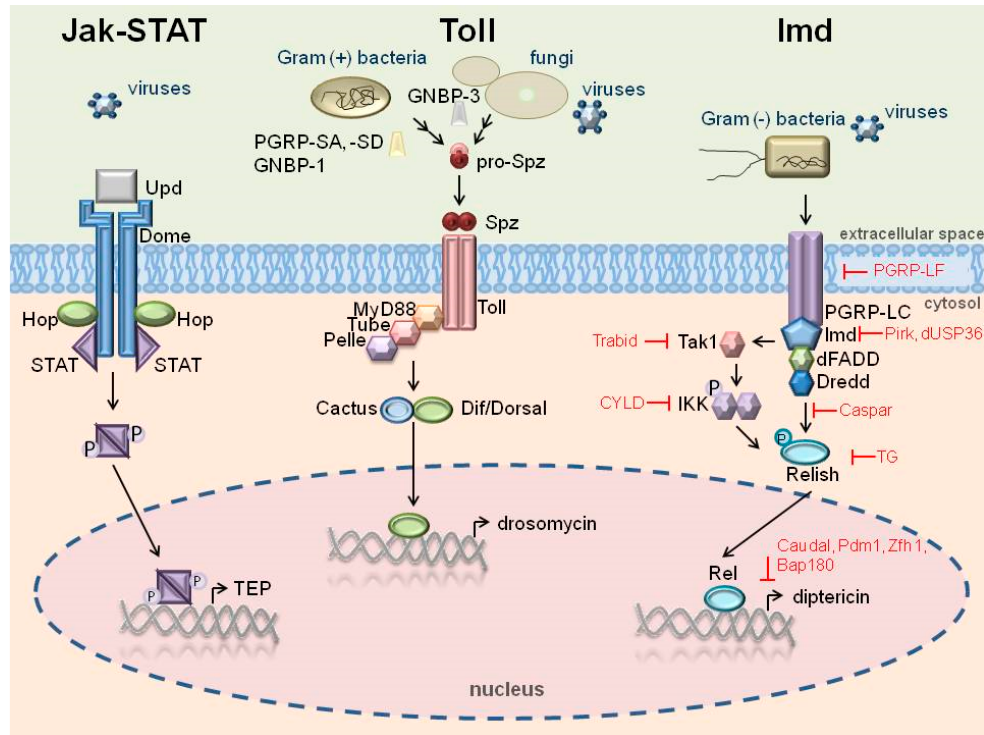
Figure 1. Main signaling pathways involved in AMP gene regulation in response to infection (simplified scheme). The Jak-STAT (Janus kinase/signal transducers and activators of transcription) pathway is induced by septic injury/damage signals or bacterial or viral infection through binding of Upd (Unpaired) cytokine to the receptor Dome (Domeless). Next, Hop (Jak kinase Hopscotch) phosphorylates Dome and STAT (Stat92E) bound to the receptor. STAT disconnects, dimerizes, and translocates into the nucleus, where it induces gene expression, e.g., TEP. The Toll pathway is activated by binding the ligand Spz (Spaetzle), which is formed from pro-Spaetzle by SPE (Spaetzle-processing enzyme) cleavage when extracellular recognition receptors PGRP-SA, -SD, and GNBP-1 recognize Gram-positive bacteria (Lys-type PGN) or GNBP-3 recognizes fungi ( β -1,3-glucan), as well as after recognizing viral infection. The activated Toll receptor (dimer) binds the adaptor protein MyD88, which recruits Tube and the kinase Pelle to form a MyD88-Tube-Pelle complex. Pelle phosphorylates Cactus (I κ B) leading to its degradation. Dorsal/Dif transcription factors released from the complex with Cactus translocate into the nucleus, where they activate the expression of AMPs. The Imd pathway is activated by transmembrane PGRP-LC receptors after recognition of Gram-negative bacteria (DAP-type PG). An adaptor protein Imd interacts with dFADD ( Drosophila Fas-associated death domain) and Dredd (Death related ced-3/Nedd2-like caspase). Activated Tak1 kinase (TGF-beta activated kinase 1) activates IKK. The NF κ B factor Relish is phosphorylated by active IKK and cleaved by Dredd to release the Rel-68 domain, which translocates into the nucleus to activate transcription of target genes. Negative regulators of the Imd pathway are indicated by